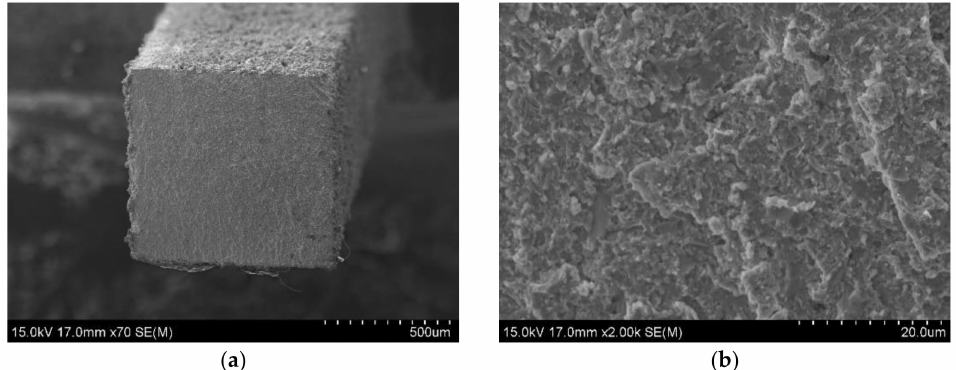
Figure 9. SEM observation on fracture surfaces of KOBO extruded Zr-16 mass% Nb material, tensile test was carried at 20 ◦ C; ( a ) the fracture surface; ( b ) the magnification of 2000x, SEM.